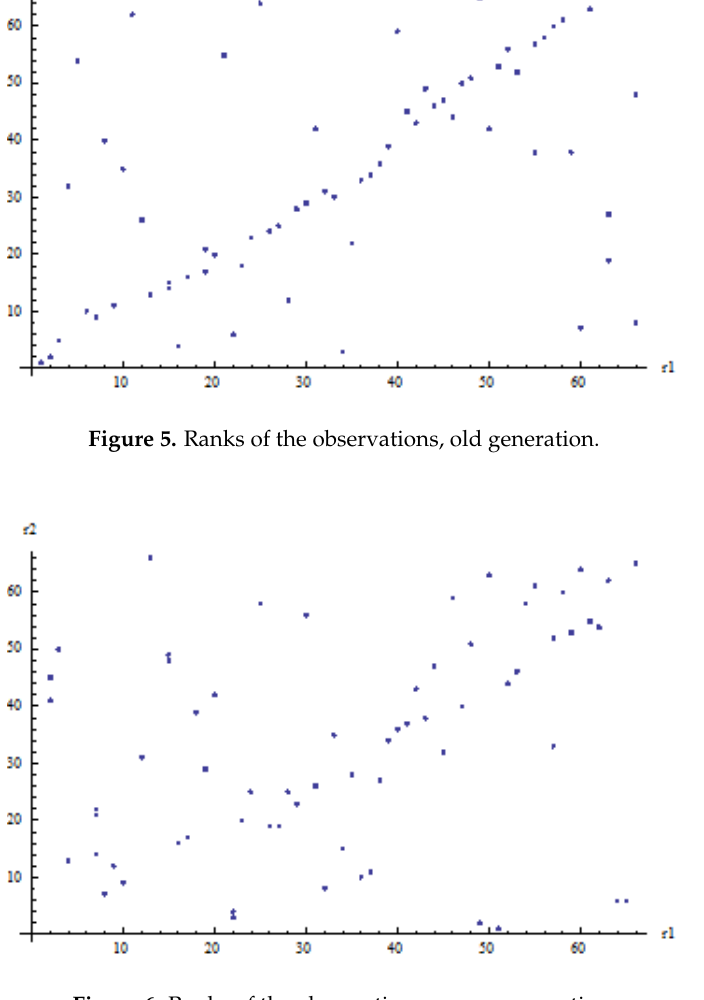
Figure 6. Ranks of the observations, young